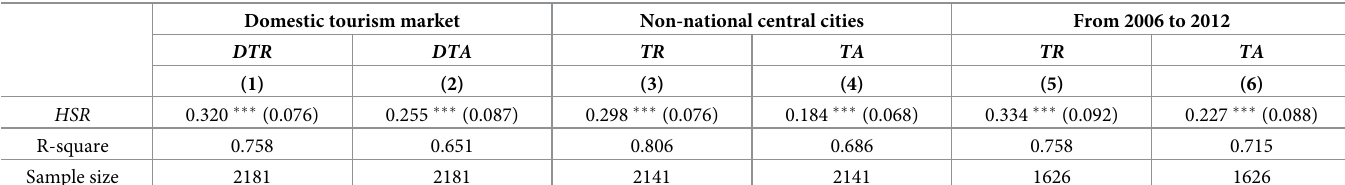
Table 4. Robustness checks with